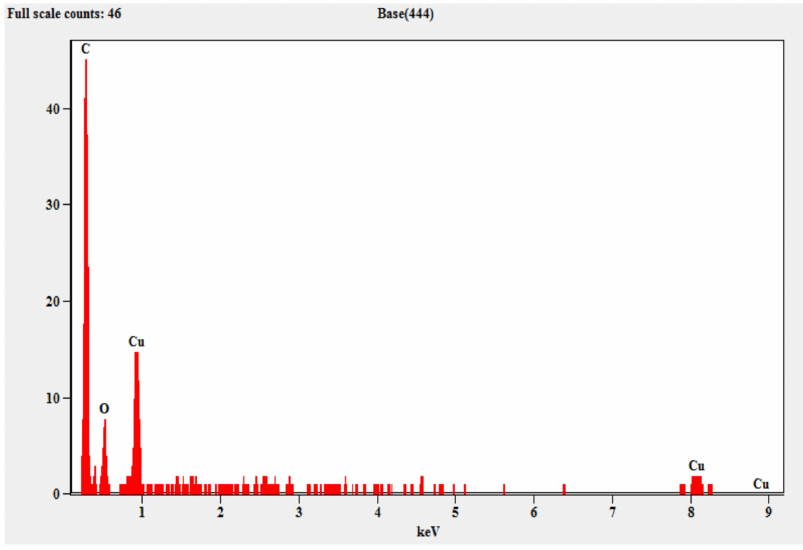
Figure 3. Telmisartan Cu-NPs of SEM images.